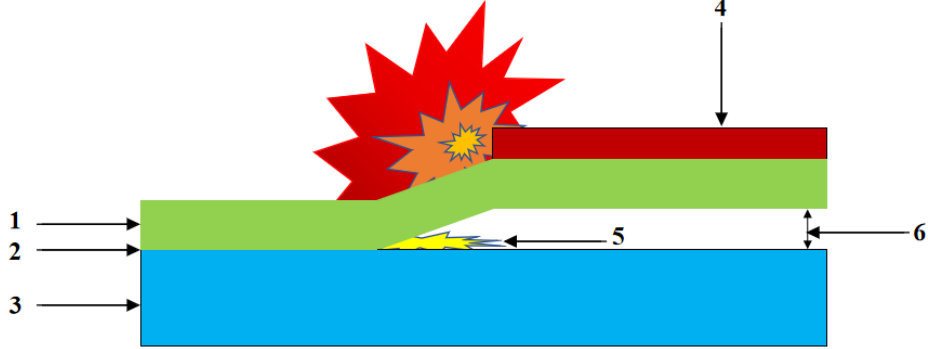
Figure 1. Schematic of explosive welding. 1, flyer plate; 2, interface; 3, collided plate; 4, explosive; 5 jetting; 6, stand-off = 5 mm or 15 mm. 5 jetting; 6, stand-off = 5 mm or 15